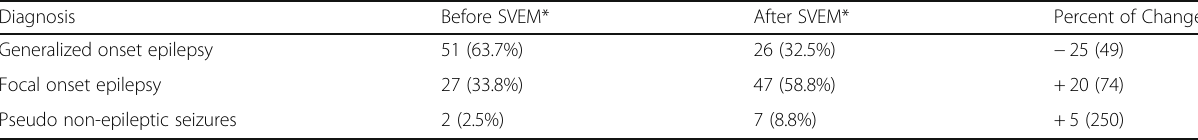
Table 3 Diagnosis of the patients before and after the short-term video EEG monitoring